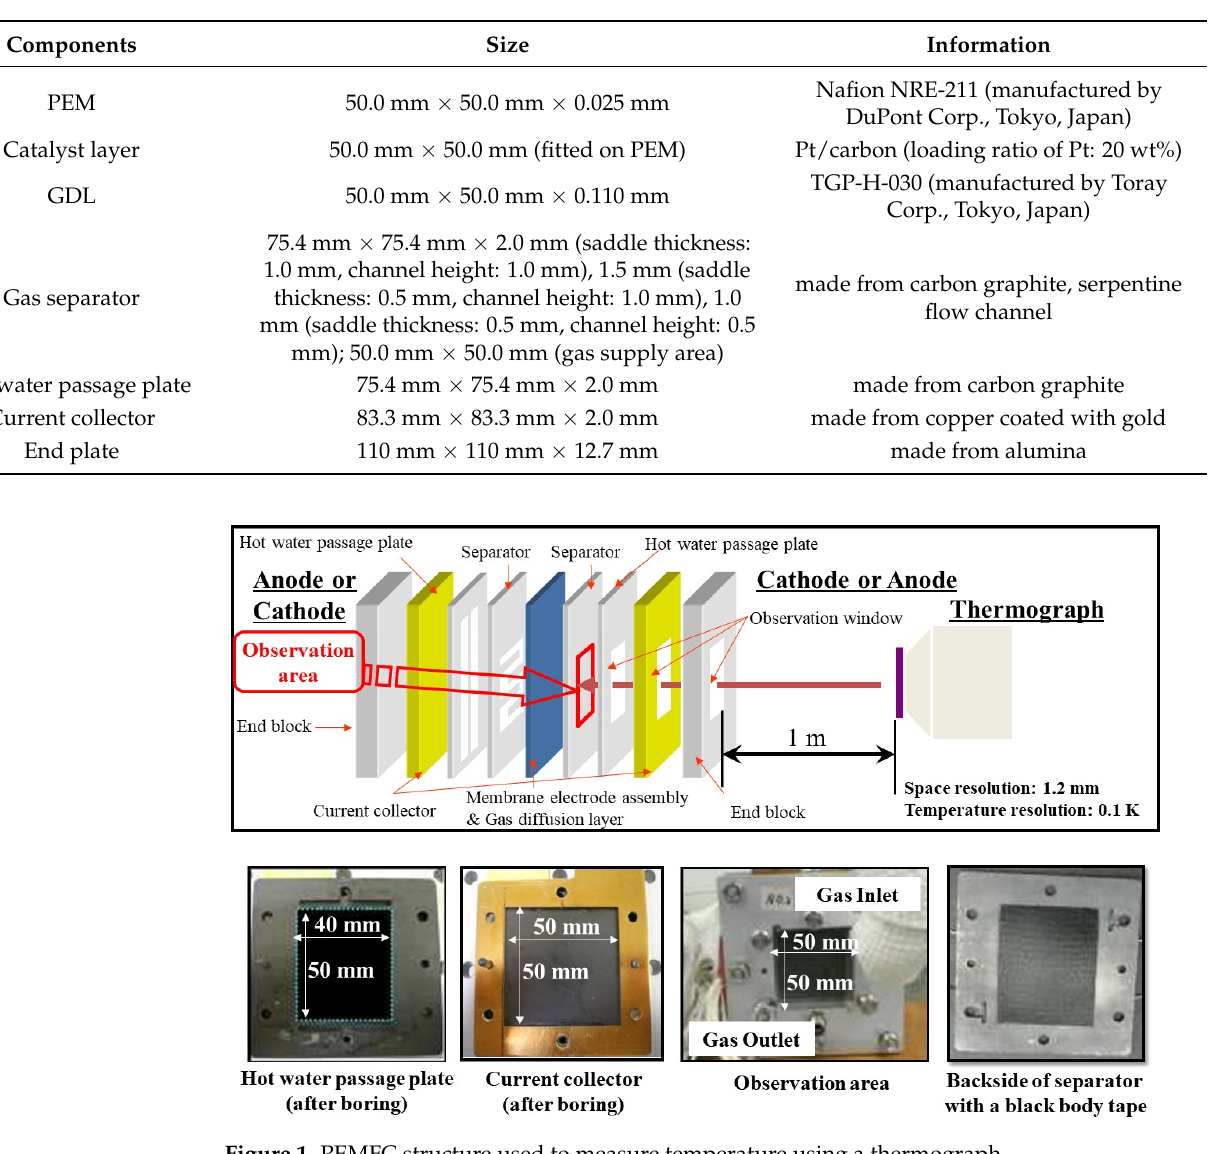
Figure 1. PEMFC structure used to measure temperature using a thermograph.